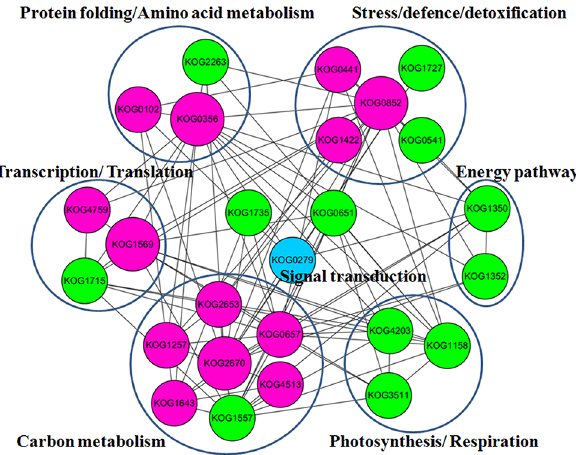
Fig 6. Network of key DAPs in NC47 involved in drought adaptation and tolerance. Interactions of the DAPs are extracted by searching the STRING database with a confidence cutoff of 0.700. The interaction network is reconstructed using the Cytoscape software. Red colour represents the upregulated proteins and green colour shows the downregulated proteins in NC47 under high PEG6000 concentration stress. Blue colour indicates the signal transduction-related